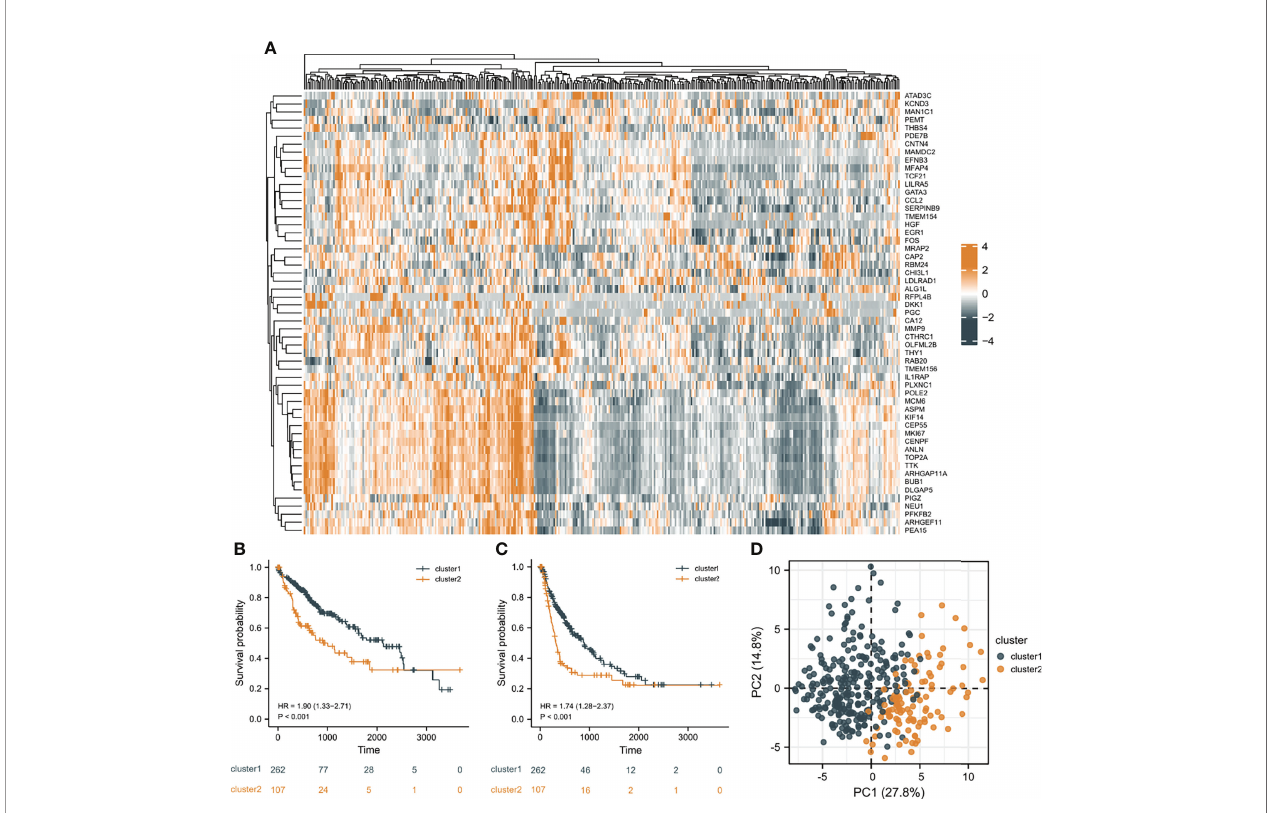
FIGURE 3 | Cluster analysis results. (A) The heat map of the expression differences of 55 CAF-related DEGs in the two clusters. (B) The overall survival (OS) difference of the two clusters. (C) The progression free interval (PFI) difference of the two clusters. (D) Principal component analysis (PCA)